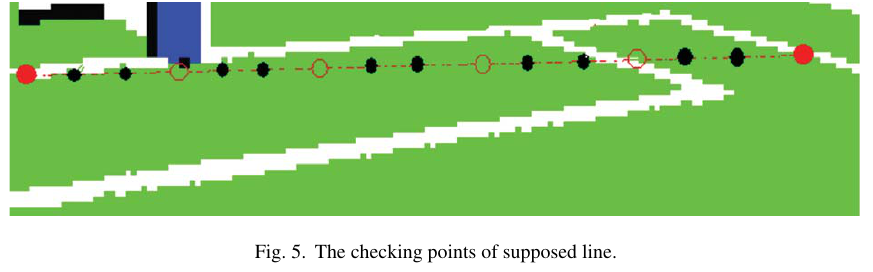
Fig. 5. The checking points of supposed line.